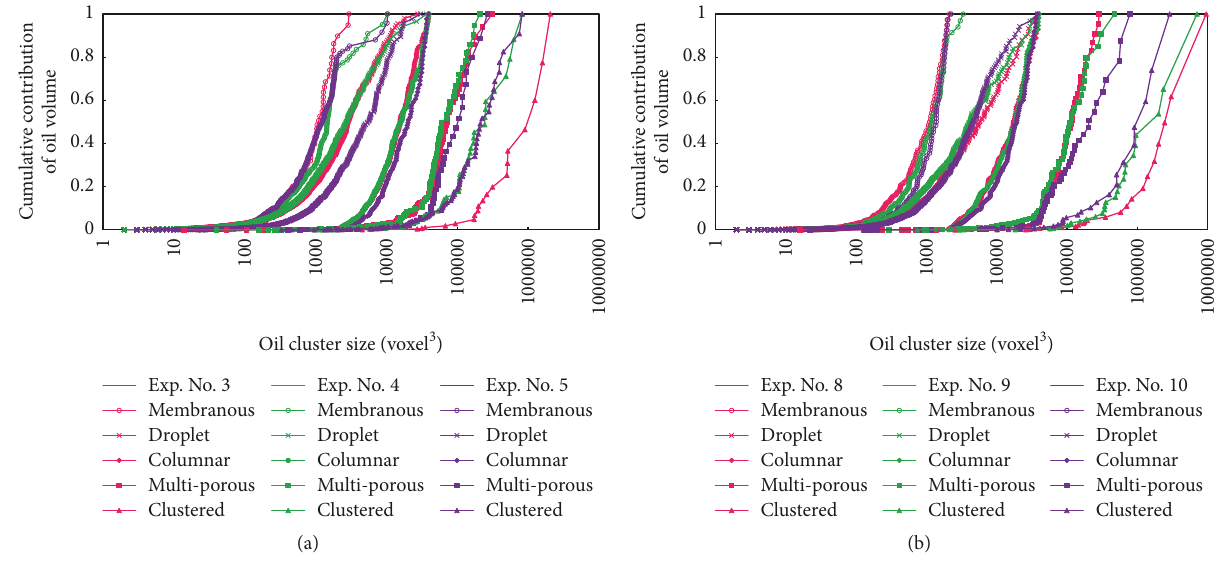
Figure 11: Cumulative contribution of various oil clusters to the overall oil volume during the water flooding experiments: (a) water-wet plug; (b) oil-wet